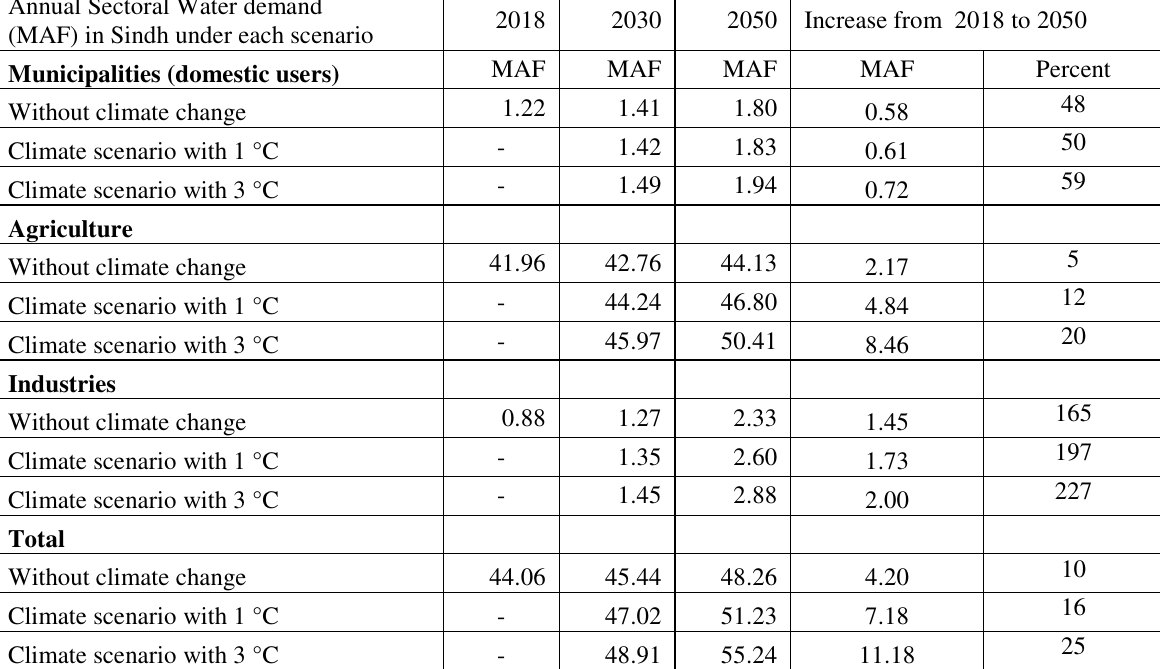
Table 6: Summary of Sectoral Water Demand in